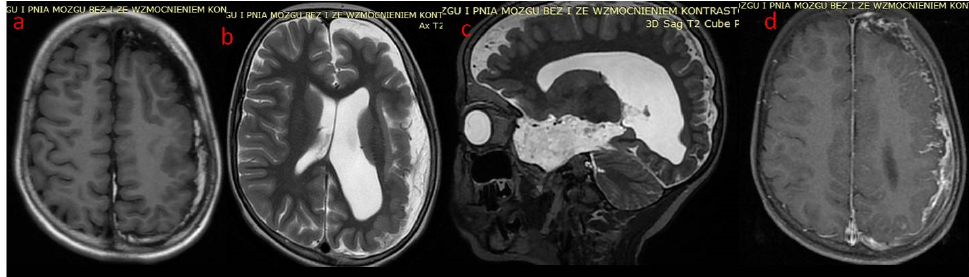
Figure 2. ( a – d ) Patient 1. Brain MR ( a ) axial T1—left-sided polymicrogyria, hemiatrophy and meningeal lipomatosis; ( b ) axial T2—left-sided hemiatrophy, ventriculomegaly and polymicrogyria; ( c ) sagittal T2—as above, and left temporal space enlargement (arachnoid cyst) with lipomatous tissue; ( d ) axial T1 with contrast—meningeal enhancement along gyri of left hemisphere.